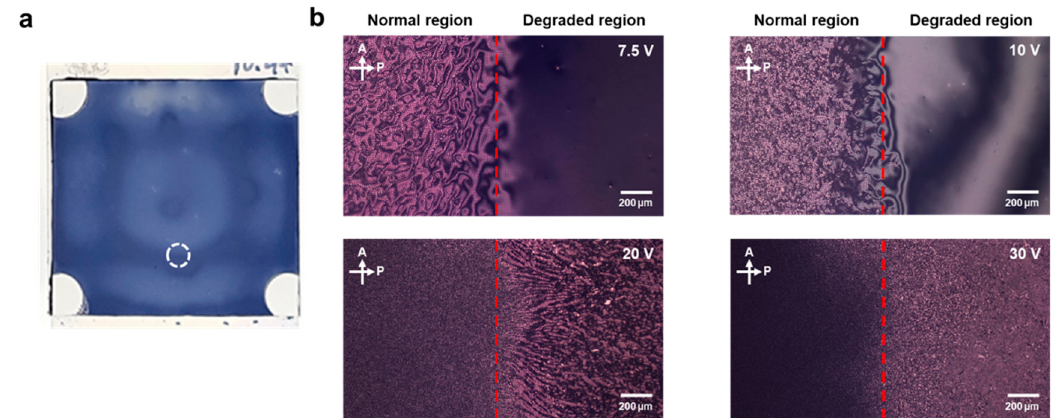
Figure 4. ( a ) The measurement points are marked as dotted circles in the photograph of the LC cell in the opaque state and ( b ) POM images of the degraded ion-doped LC cell at the boundary between the normal and degraded regions at applied voltages of 7.5, 10, 20, and 30 V.